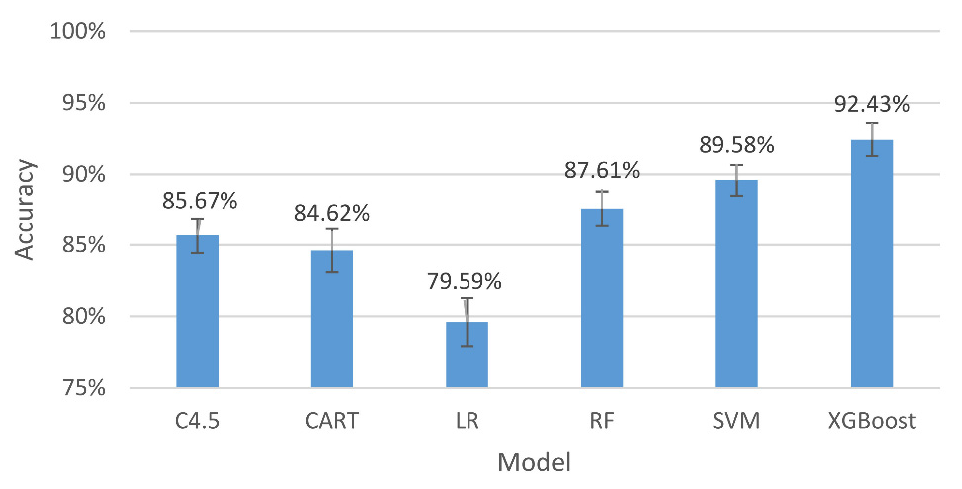
Figure 6. The accuracy and 95% confidence intervals of the generalizing models for the two-level classification (mid and low stresses).